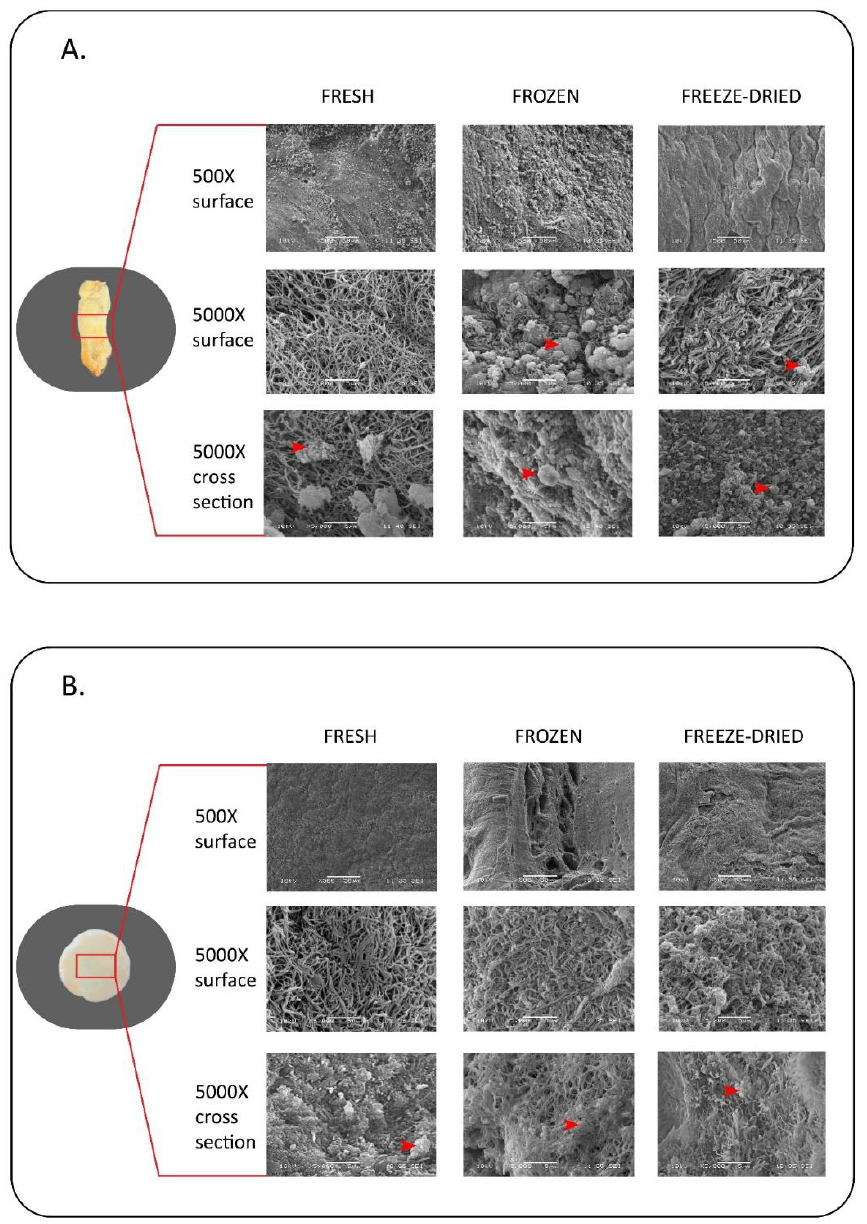
Figure 4. Scanning electron microscope imaging of PRF membranes. The surface microstructure of fresh, frozen and freeze-dried PRF created by the classical glass tube method (GT) is shown in ( A ) and PRF created by the single-syringe closed system (HI) on ( B ). The middle portion of the surface of each membrane was scanned using 500 × and 5000 × magnifications. The cross-sections of the samples were monitored using 5000 × magnification. Red arrows show the platelets on the surface and on the inside of the